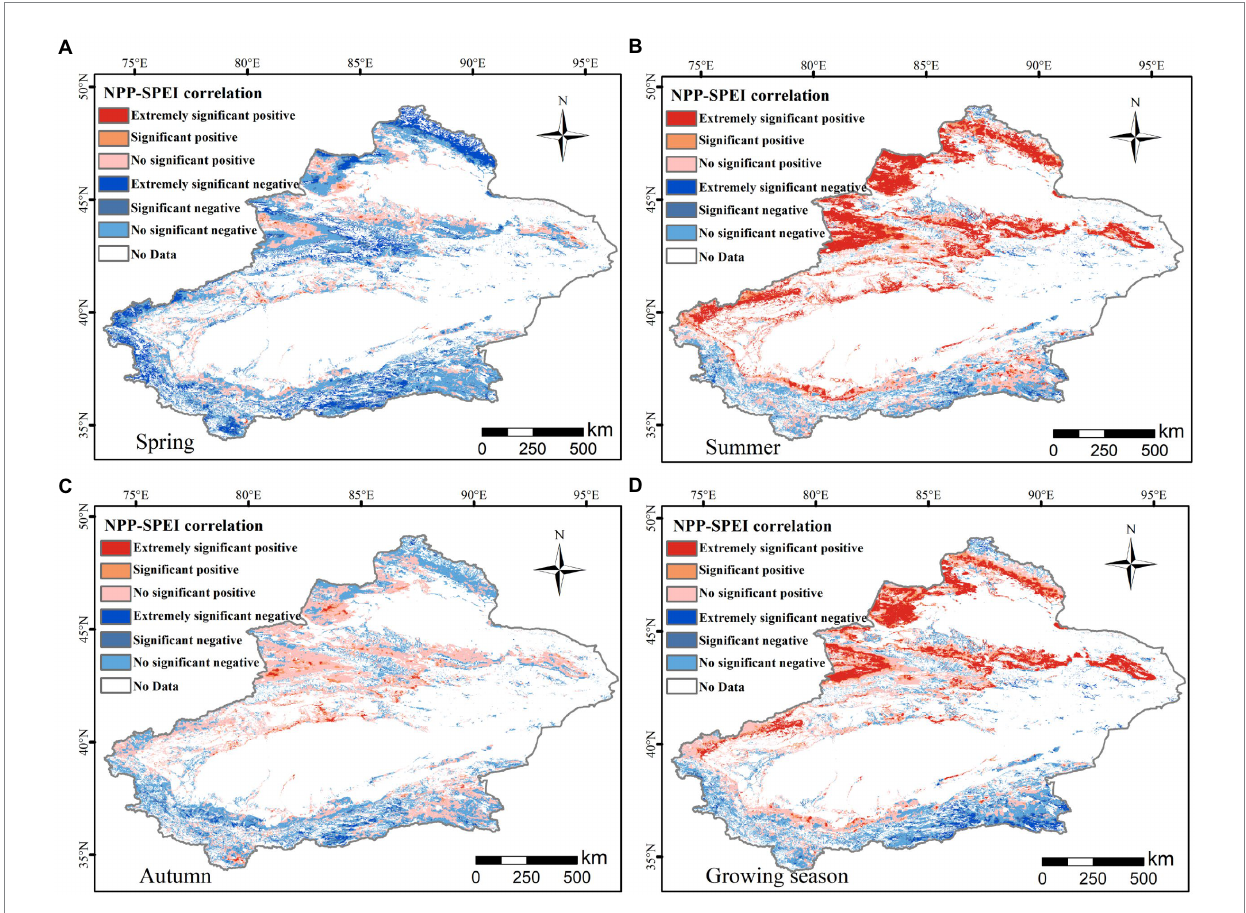
FIGURE 8 Spatial pattern distribution of NPP and SPEI correlations in (A) spring, (B) summer, (C) autumn, and (D) the growing season in Xinjiang from 1982 to